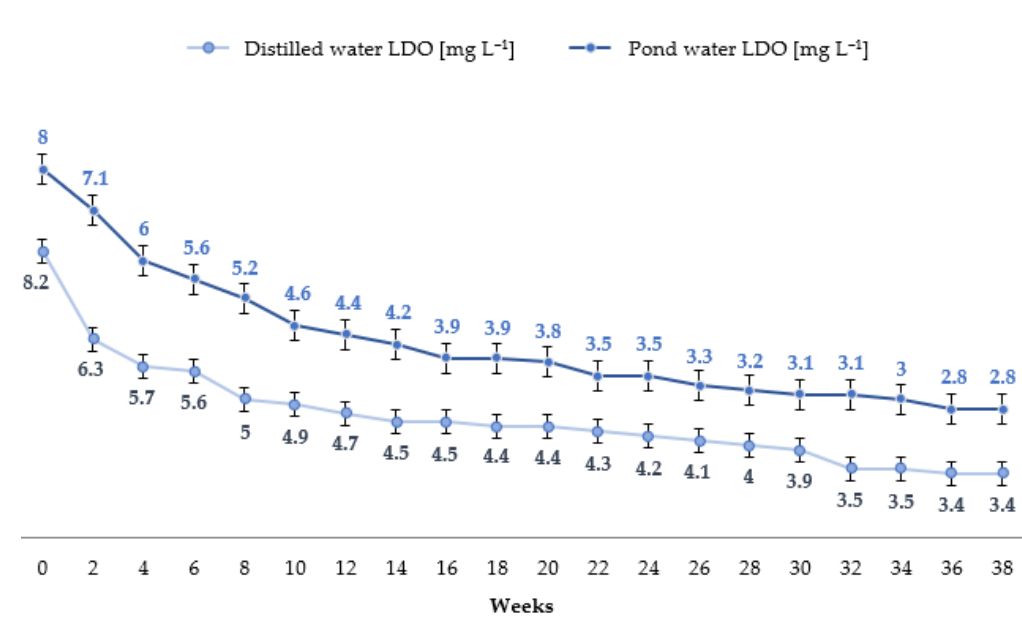
Figure 5. Recorded parameters of EC ( μ S cm − 1 ) in leachates from tire fractions in distilled water and in recipient water.